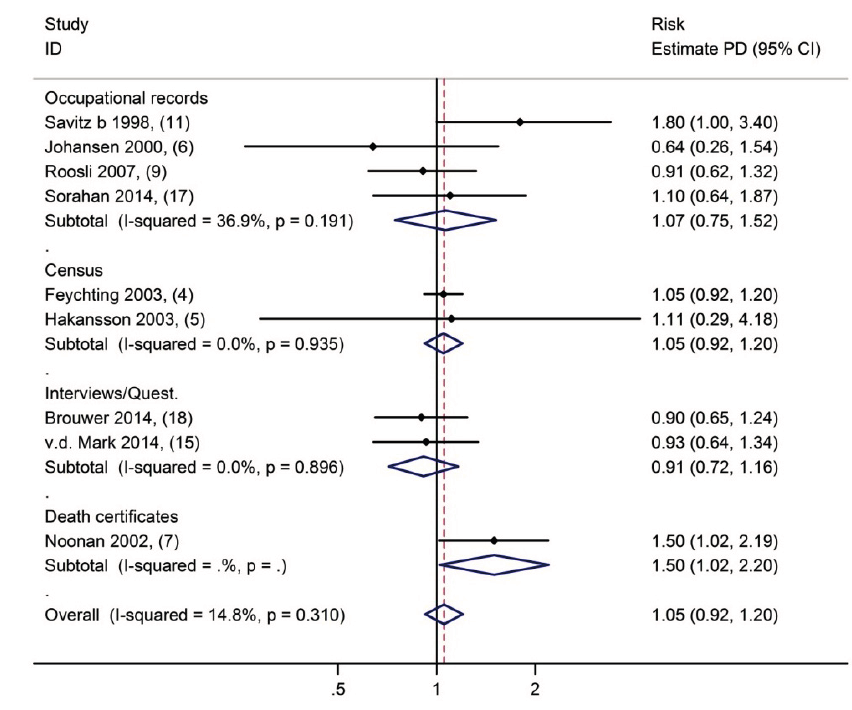
Figure 2. Parkinson’s disease in association with occupational exposure to extemely-low-frequency magnetic fields. Comparing highest-longest to lowest exposure to extremely-low-frequency magnetic fields (Numbers in brackets pertain to